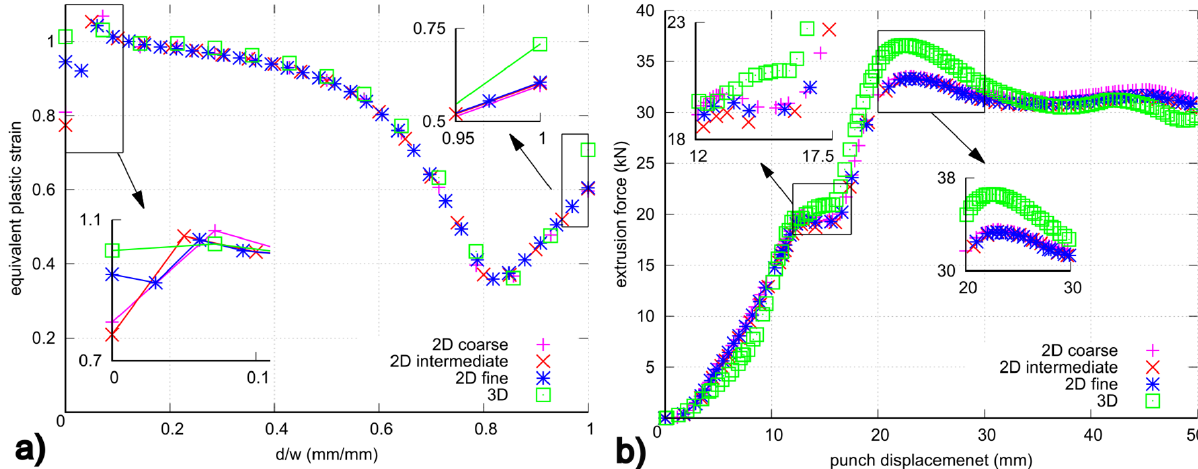
Figure 8. ( a ) Equivalent plastic strain at 21 points indicated in Figure 5; ( b ) extrusion force obtained with the meshes shown in Figure 7.